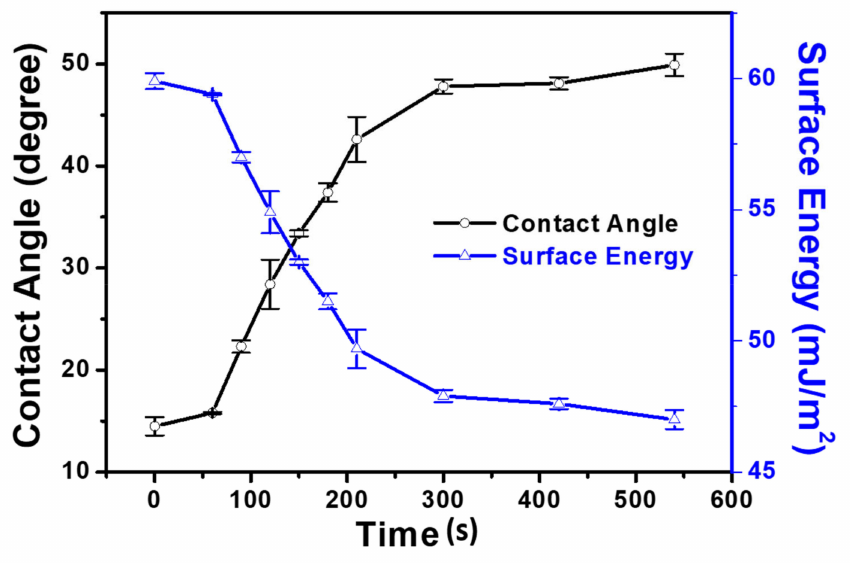
Figure 4. Plot of water contact angle (degree) and surface energy (mJ/m 2 ) versus time for